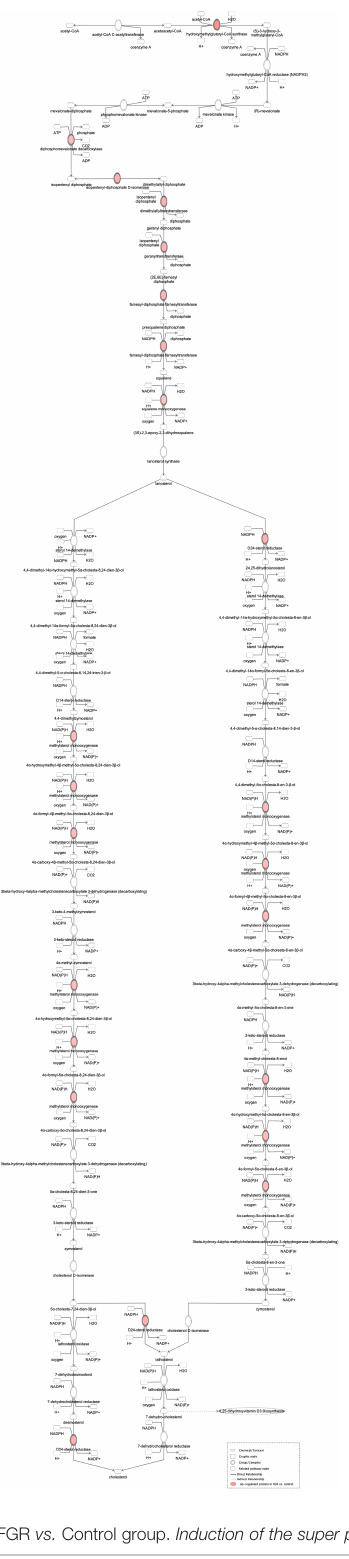
Frontiers in Endocrinology |